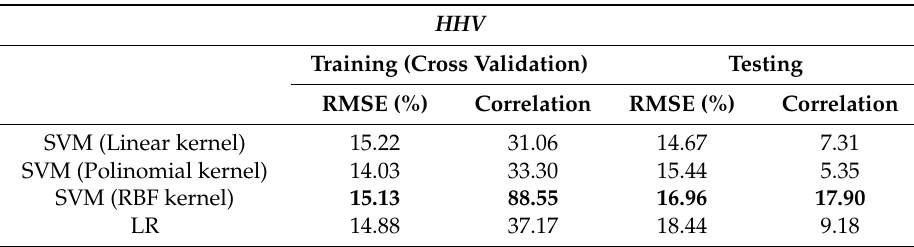
Table 12. Results obtained during the training and testing stages for HHV